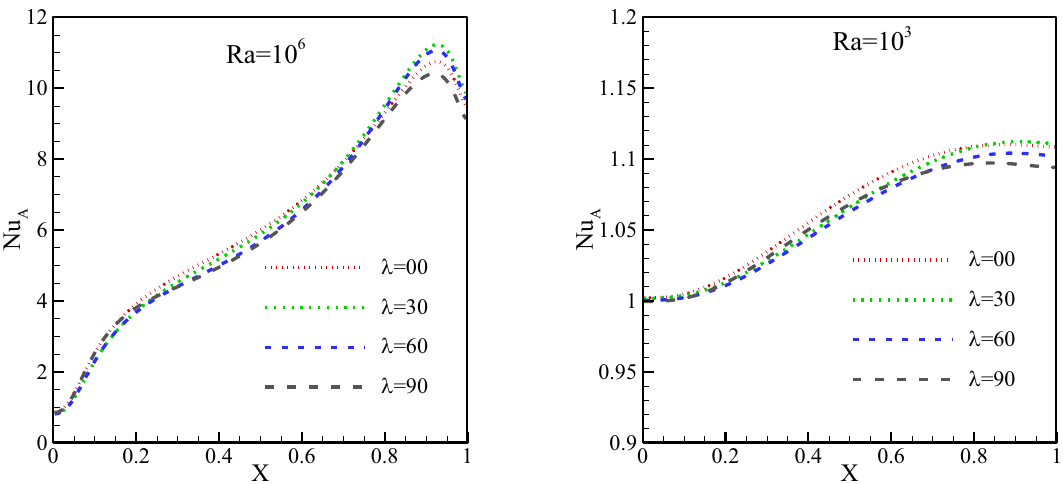
Figure 11. Local Nu on the cold wall for a Ra of ( a ) 10 3 and ( b ) 10 6 and different MF angles at φ = 0.3, γ = 45°, Ha = 20, Rad = 1.